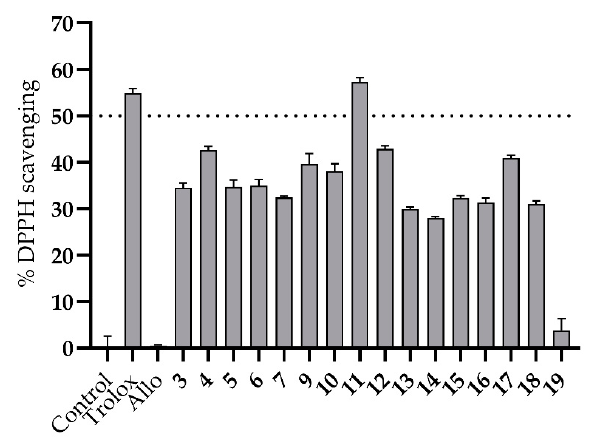
Figure 2. In vitro DPPH radical scavenging activity of bis-thiobarbiturates 3 – 7 and 9 – 19 , Allo and reference Trolox. Results are expressed as average values ± SD of two independent determinations, and each one was performed in triplicated. A p < 0.001 versus the negative control in the statistical significance analysis (Student’s t -test) was observed for all compounds except for Allo and 19 .